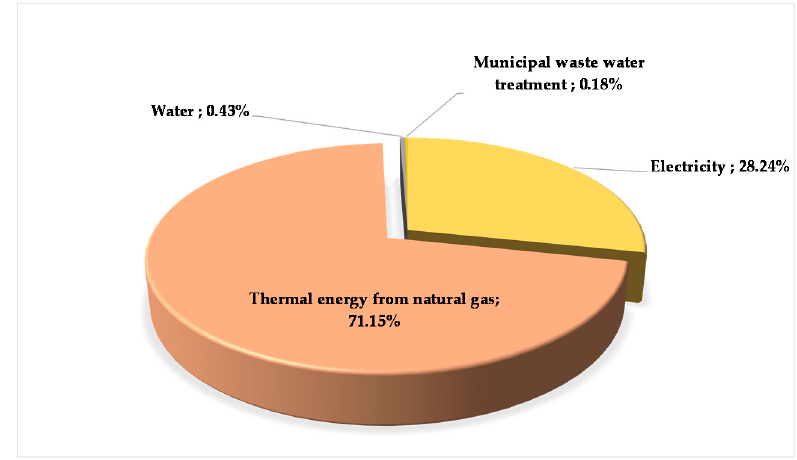
Figure 5. Relative contribution percentage of material and energy flows in the use phase.